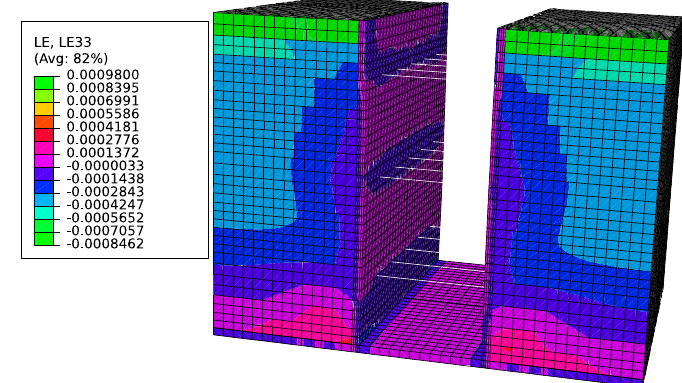
Figure 9. Response (bending strain) of the updated numerical model.